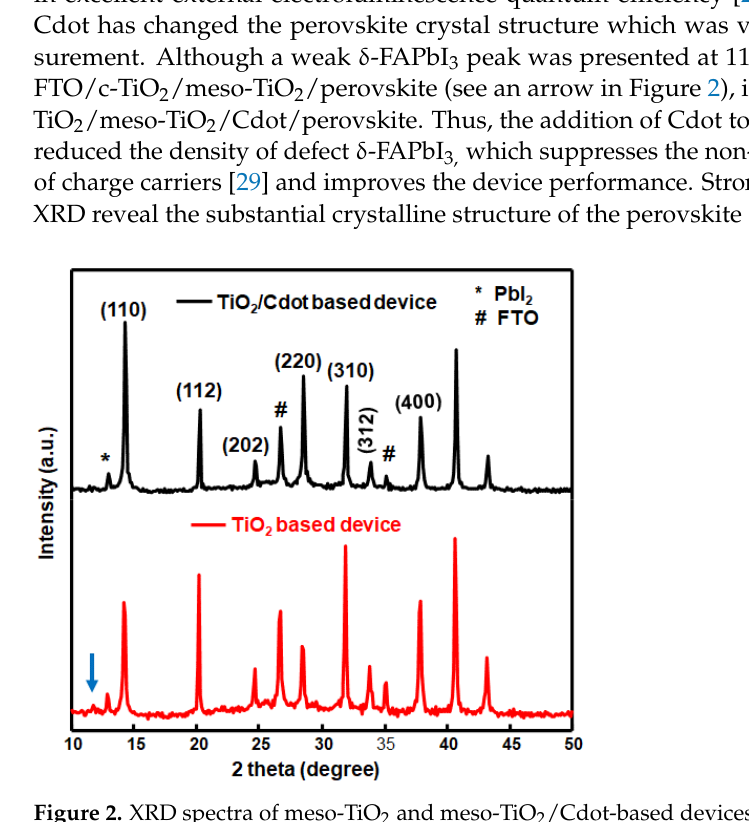
Figure 2. XRD spectra of meso-TiO 2 and meso-TiO 2 /Cdot-based devices. A peak marked by a blue arrow is attributed to a photoinactive phase of δ -FAPbI 3 .